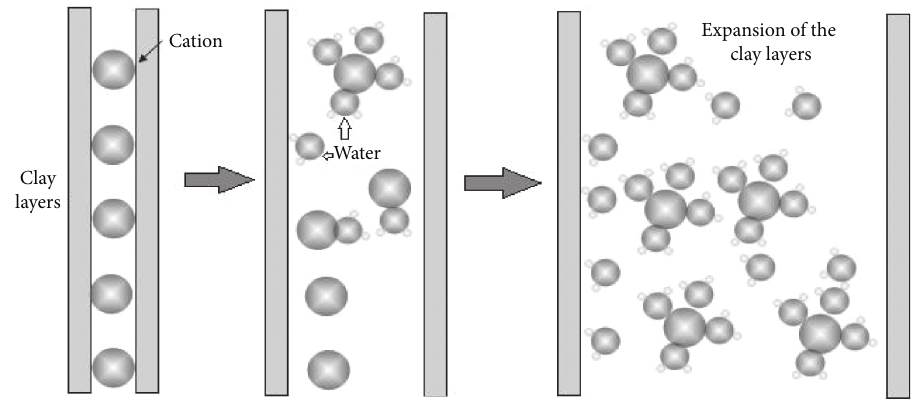
Figure 2: Clay-water